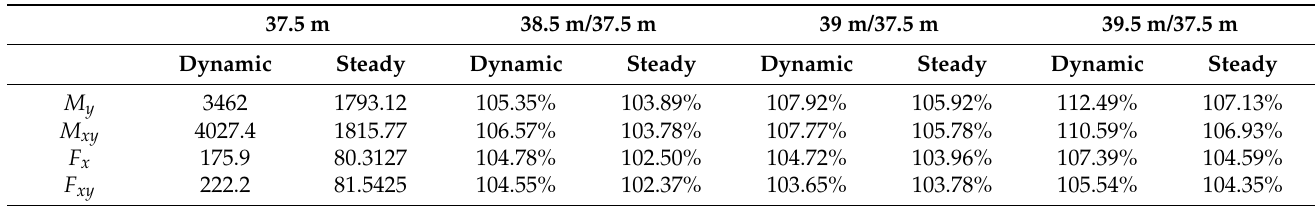
Table 15. The main ultimate loads affected by blade extension on the blade root.